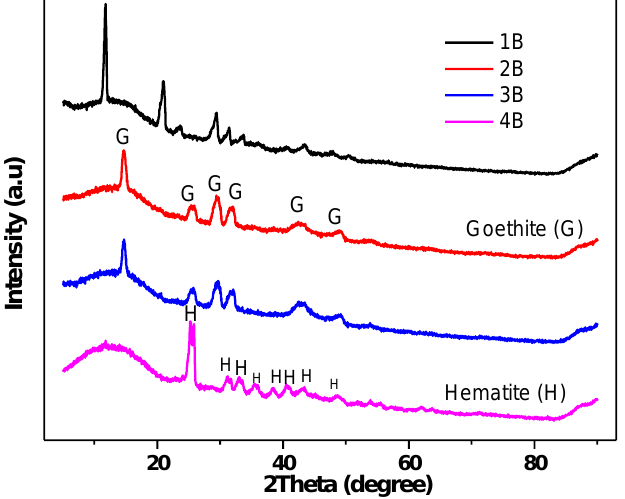
Figure 14. XRD patterns of Nanoparticles (NPs) samples produced from AMD. Notes: 1B = (25 ◦ C-CaCO 3 as alkali); 2B = Goethite (150 ◦ C-CaCO 3 as alkali); 3B = Goethite (300 ◦ C-CaCO 3 as alkali); 4B = Hematite (800 ◦ C-CaCO 3 as alkali).